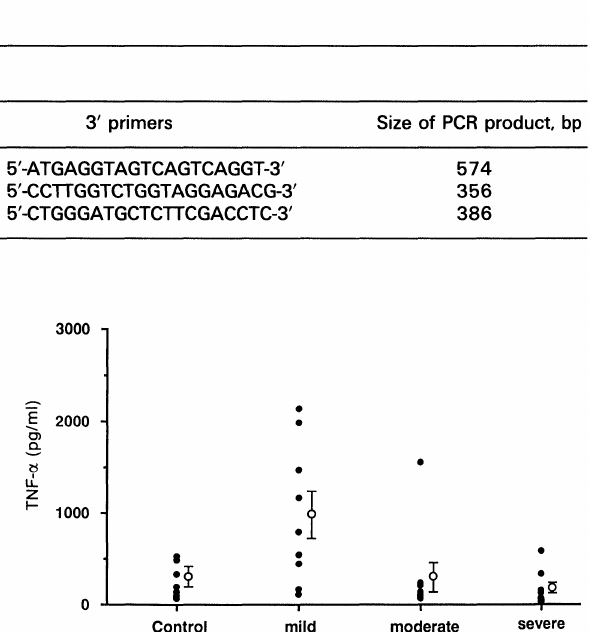
FIG. 1. Correlation between TNF- in nasal secretions and clinical severity. There was no correlation between TNF- in nasal secre- tions and clinical severity in perennial nasal allergy patients, although the mean concentration in mild nasal allergic patients was significantly higher than that in normal subjects (p < 0.05).